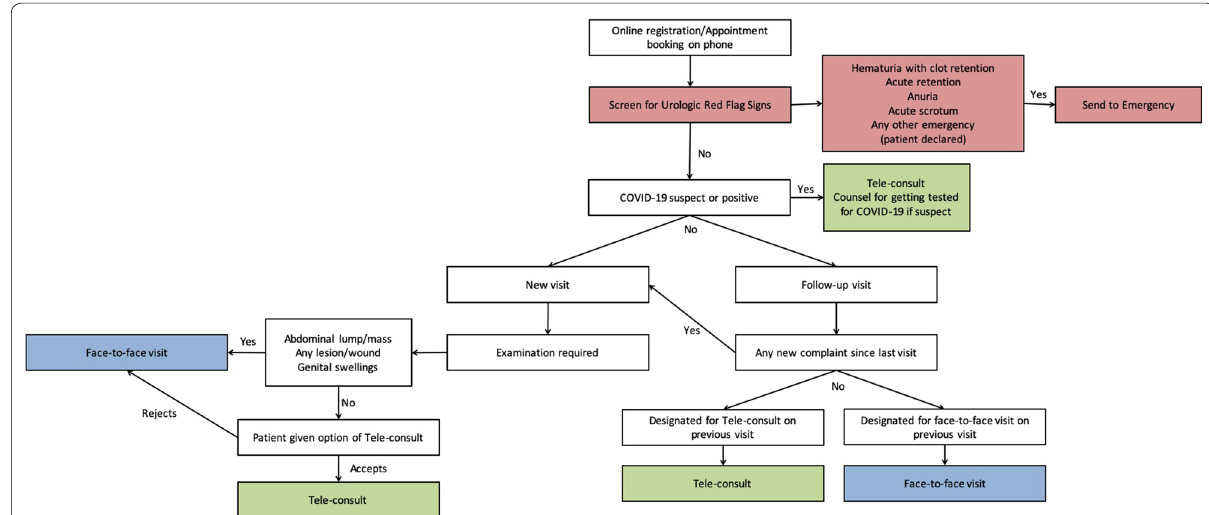
Fig. 1 Proposed algorithm for incorporation of telemedicine in urologic outpatient care